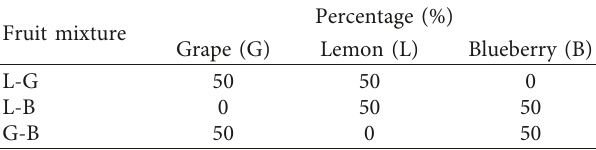
Table 1: Mixture